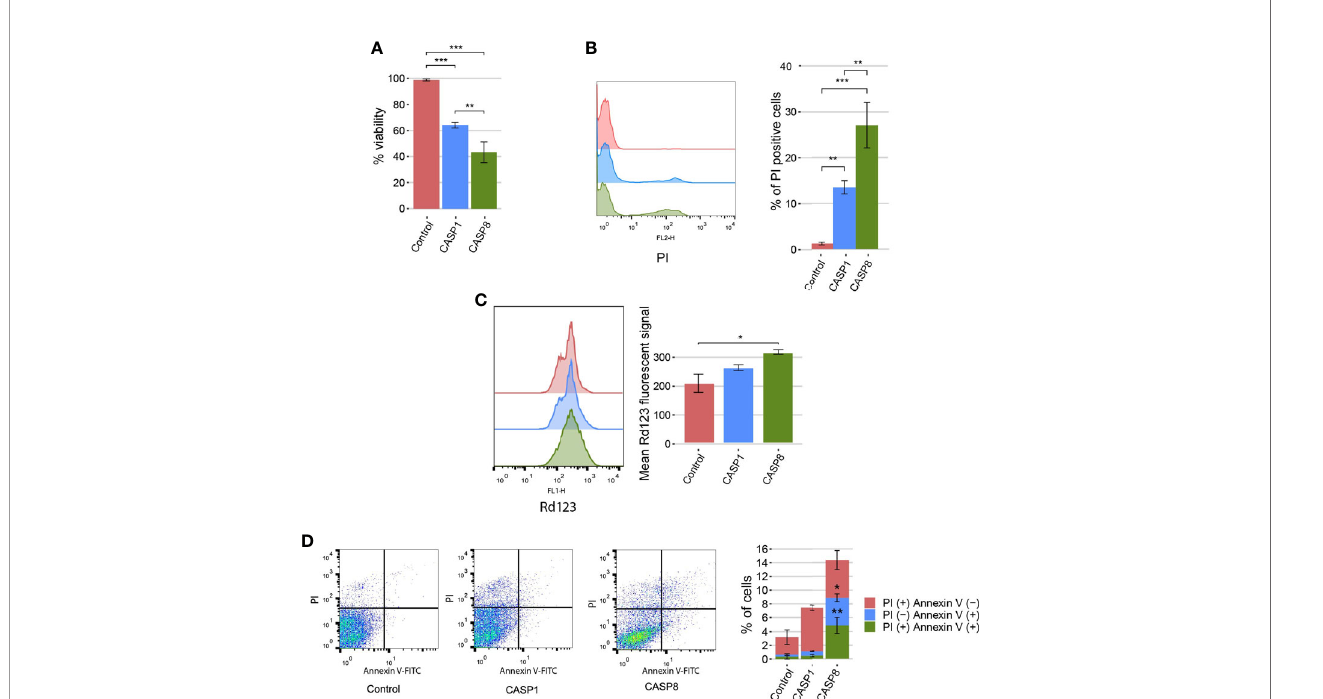
FIGURE 3 | Caspase-1 and caspase-8 cause reduction in cell viability, cell death, and mitochondrial membrane hyperpolarization. (A) Graph showing the percentage of viable cells determined by a cell viability assay of BY4741 strain bearing the same plasmids as in Figure 1B after 5 h of induction in SG medium. (B) Stacked histograms (n=10,000) showing PI fl uorescent signal by fl ow cytometry in abscissae (left panel) and graph showing the percentage of positive PI-stained cells of each population (right panel) of BY4741 strain bearing the same plasmids as in panel (A) . (C) Stacked histograms (n=10,000) showing Rd123 fl uorescent signal by fl ow cytometry in abscissae (left panel) and graph showing the mean Rd123 fl uorescent signal of each population (right panel) of BY4741 strain bearing the same plasmids as in panel (A) . (D) Dot plots (left panels) and stacked bar graph (right panel) showing the percentage of PI (+) annexin V ( − ), PI ( − ) annexin V (+), and PI (+) annexin V (+) cells of BY4741 strain bearing the same plasmids as in panel (A) . Only data from caspase-1 and caspase-8 were considered for comparison in this case. Results correspond to the mean of three biological replicates performed on different clones in all cases. Error bars represent SD. Asterisks (*, **, ***) indicate a p value < 0.05 by Dunn ’ s test in panel (A) , and a p-value < 0.01 and 0.001, respectively, by the Tukey ’ s HSD test in panels (B, C) . In panel (D) , asterisks (*, **) represent a p-value < 0.05 and 0.01, respectively, by Student ’ s